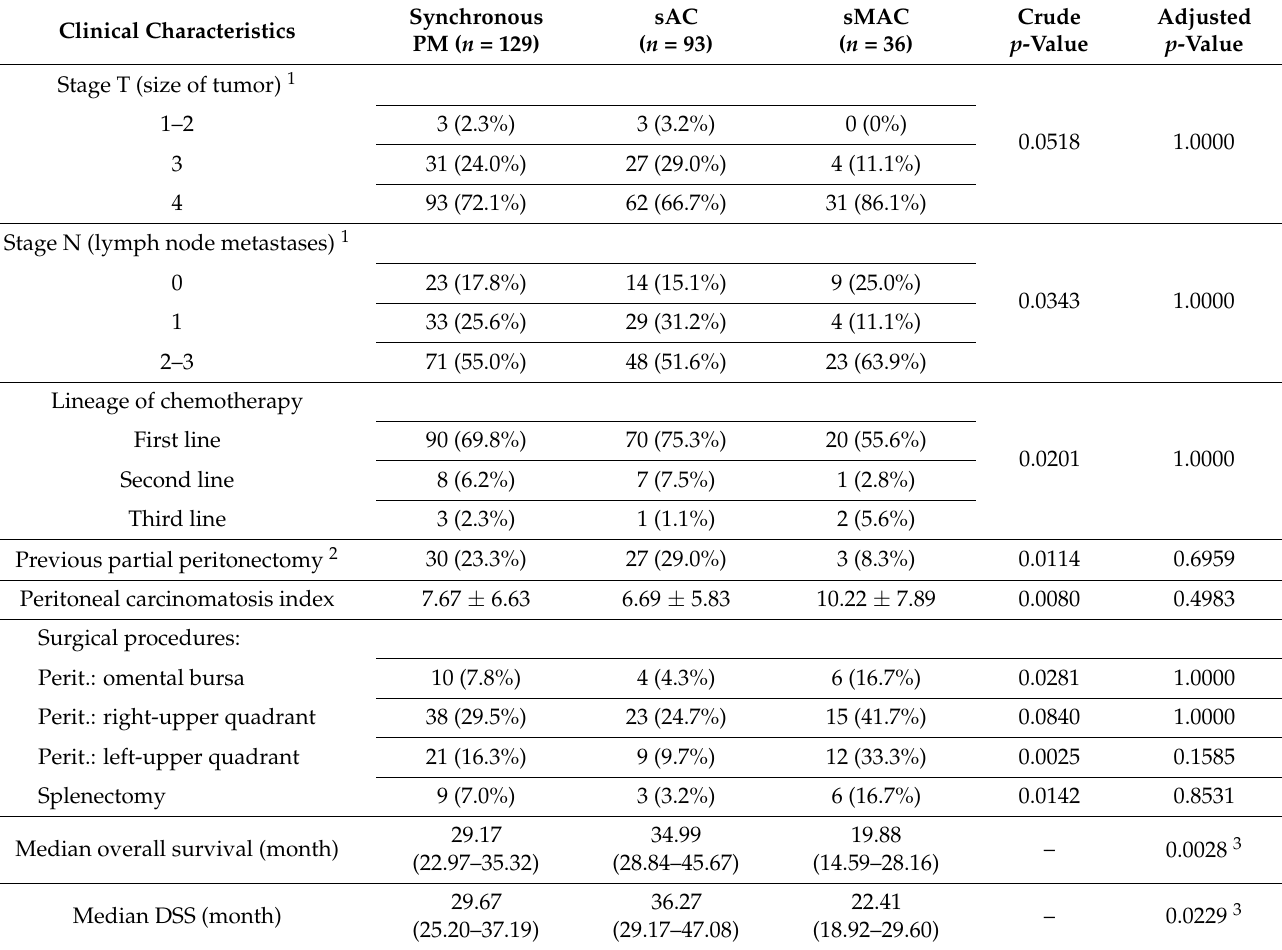
Table 1. Pre-, peri-, and postoperative demographic and clinical characteristics of study participants with synchronous peritoneal metastases (PM). Unit of frequency and survival data are the number of observations (percentage) and the median survival time (95% confidence interval), respectively. Further parameters are presented in Supplementary Table